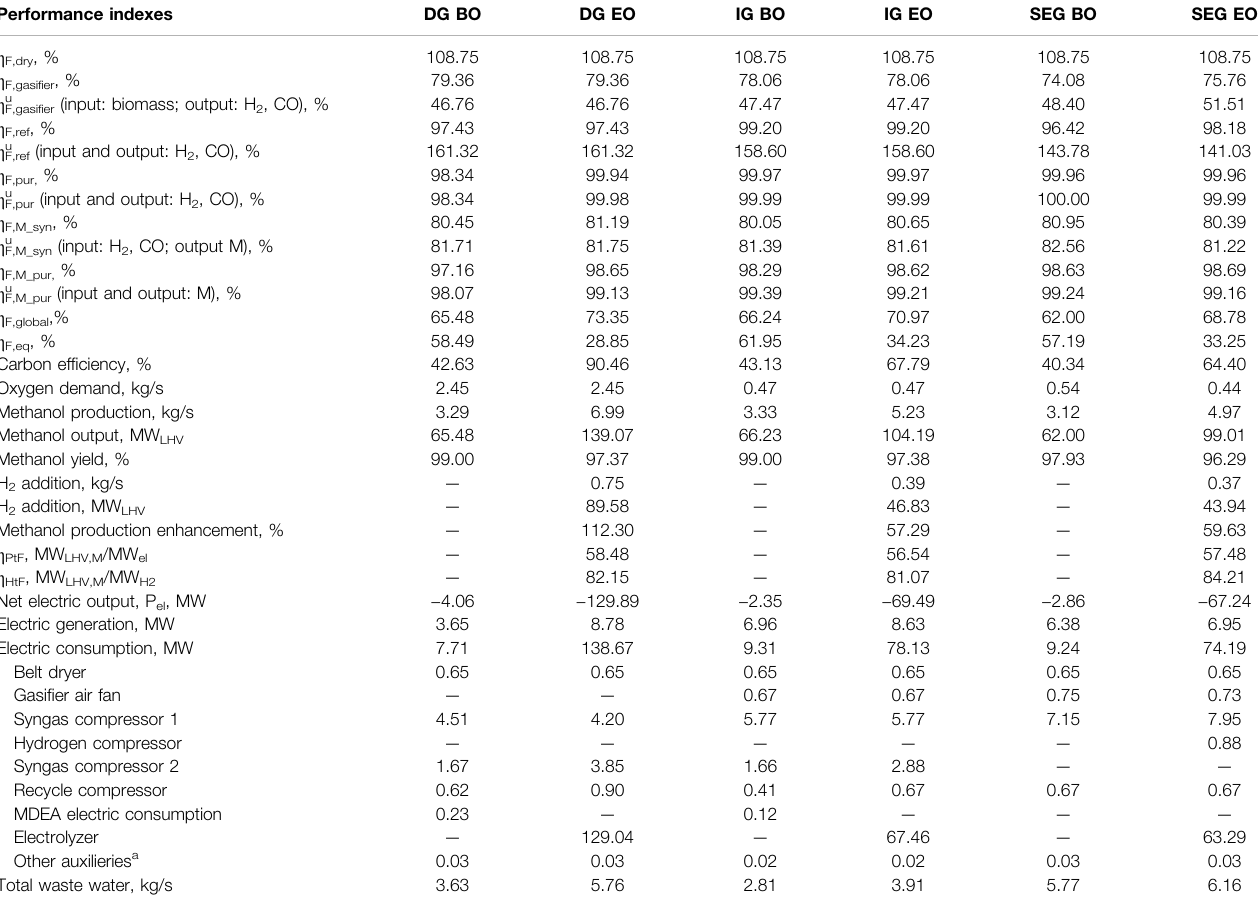
TABLE 7 | General performance of the power and biomass-to-methanol plants. Performance